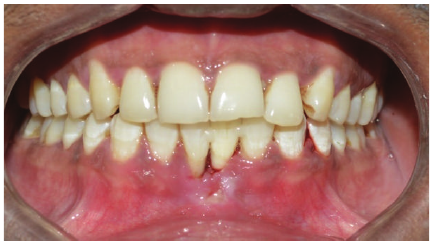
Figure 6: Trial placement of fibre.